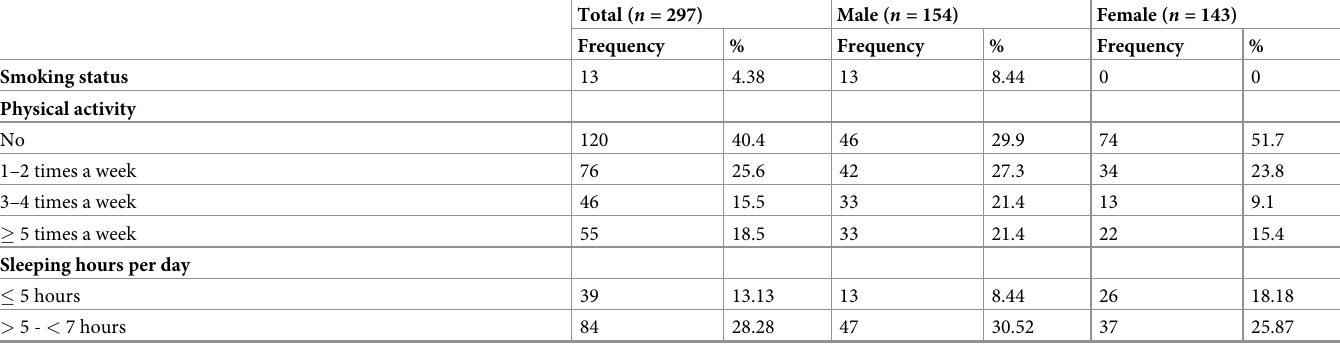
Table 2. Lifestyle Characteristics of the study population stratified by